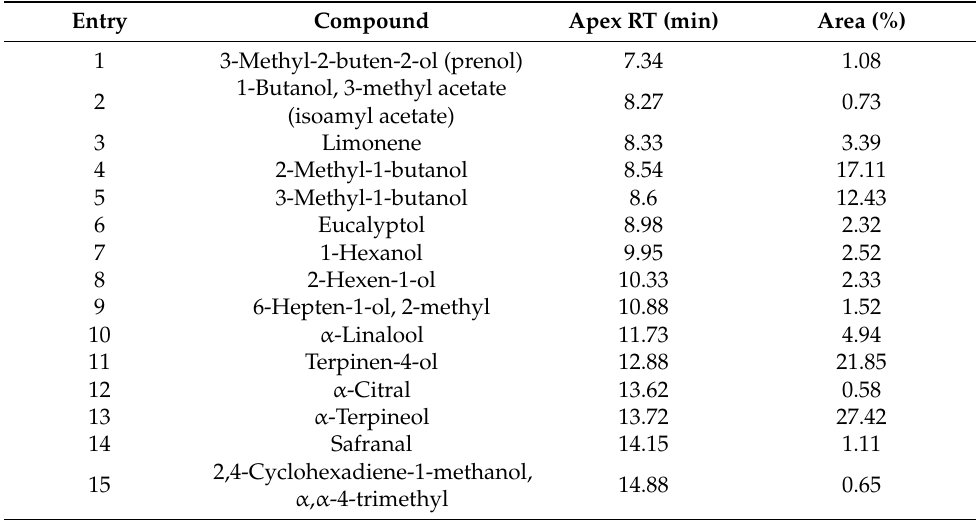
Table 1. Volatile organic compounds in the lemon IntegroPectin.